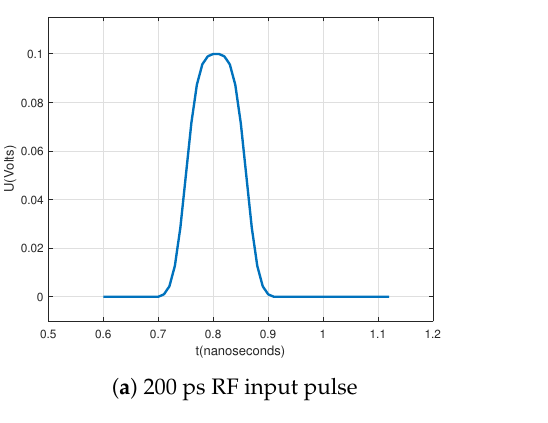
Figure 8. Simulation result of